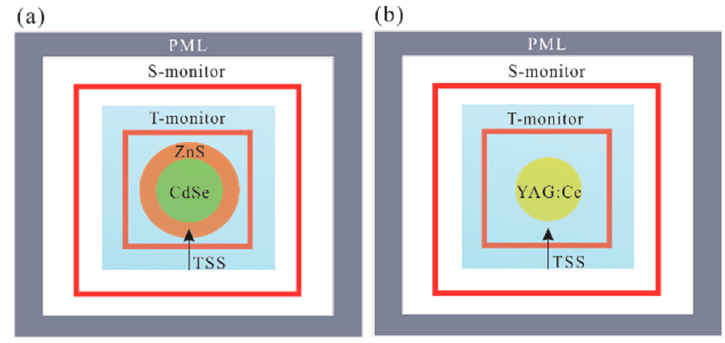
Figure 1. Finite-difference time-domain (FDTD) modeling of ( a ) CdSe/ZnS quantum dot (QD) and ( b ) YAG phosphor. PML: perfectly matched layer; TSS: total-field scattered-field source.